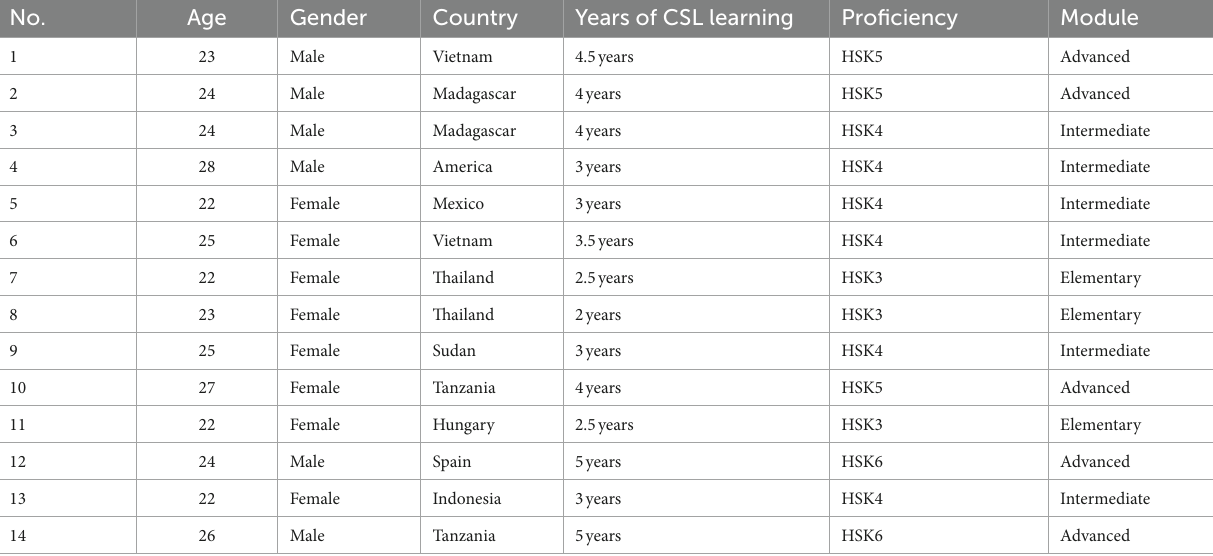
TABLE 2 The student interviewees’ backgrounds.